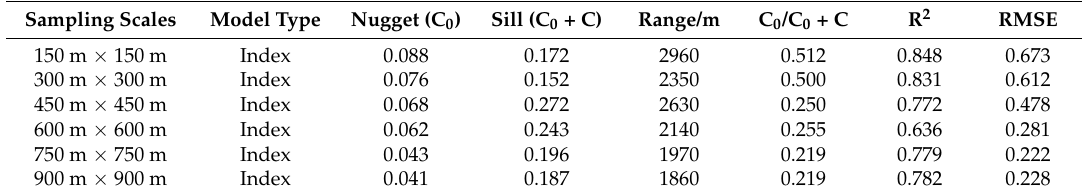
Table 2. Semi-variance model of rock exposures and its fitting parameters under different sampling scales. Sampling